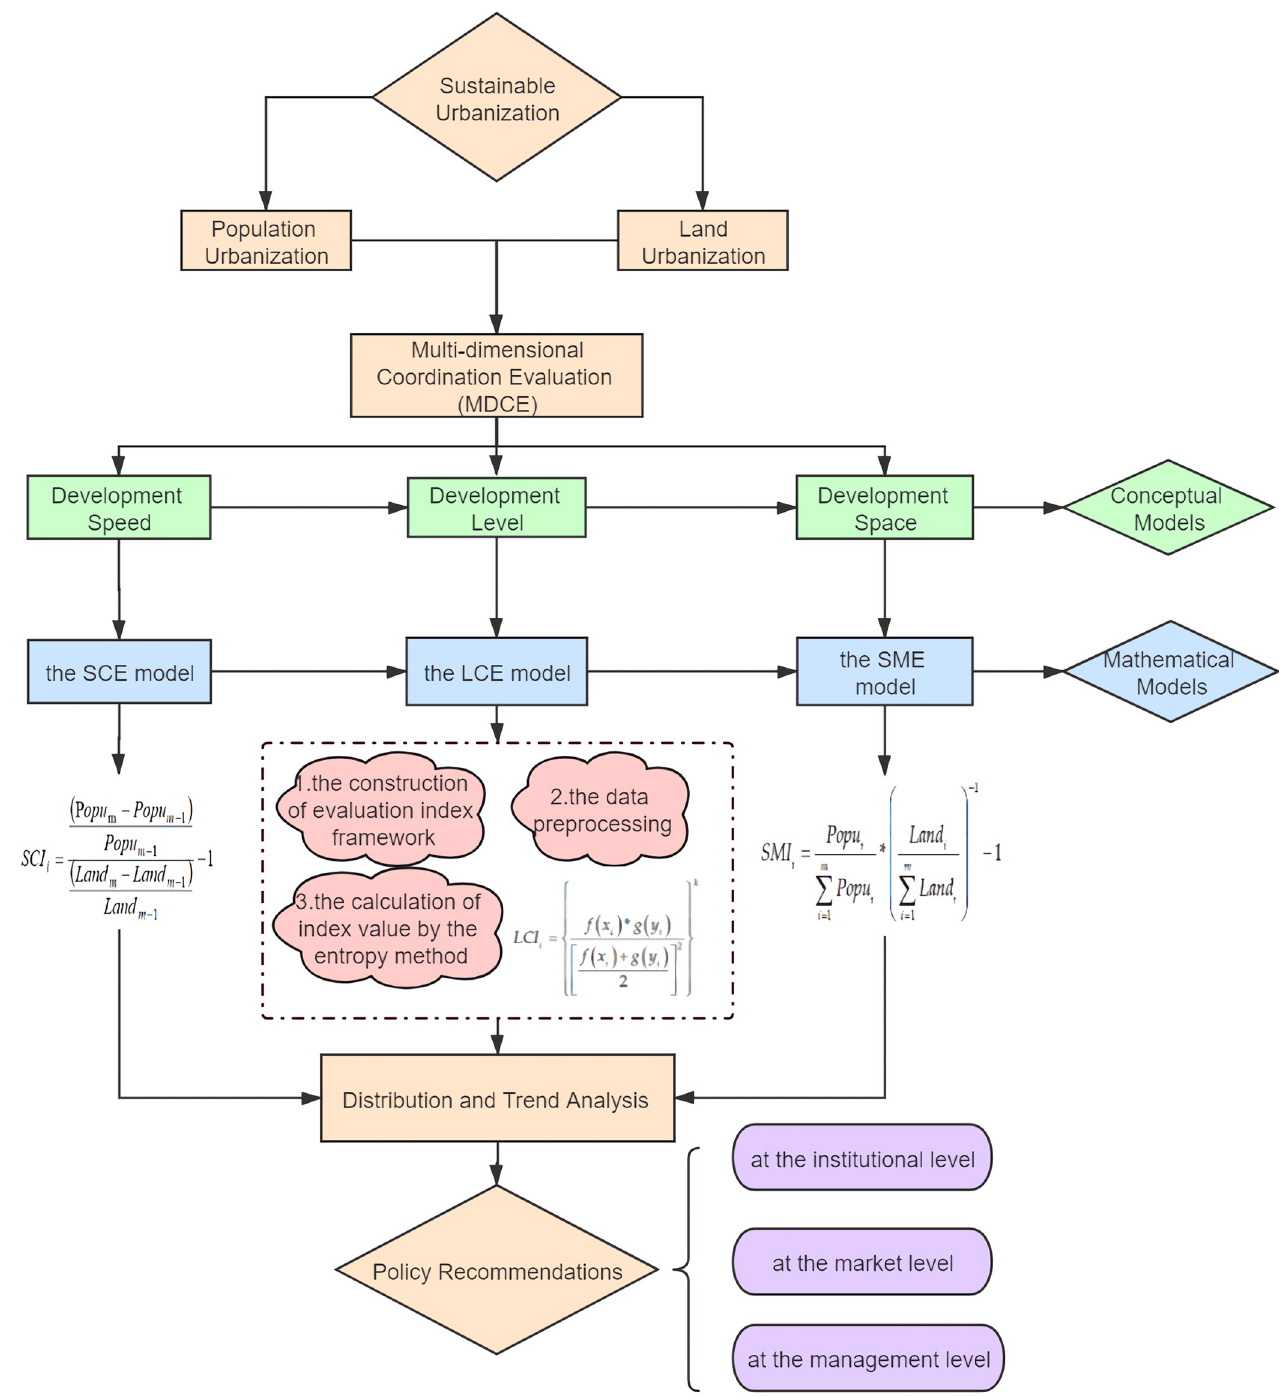
Fig 2. The framework of